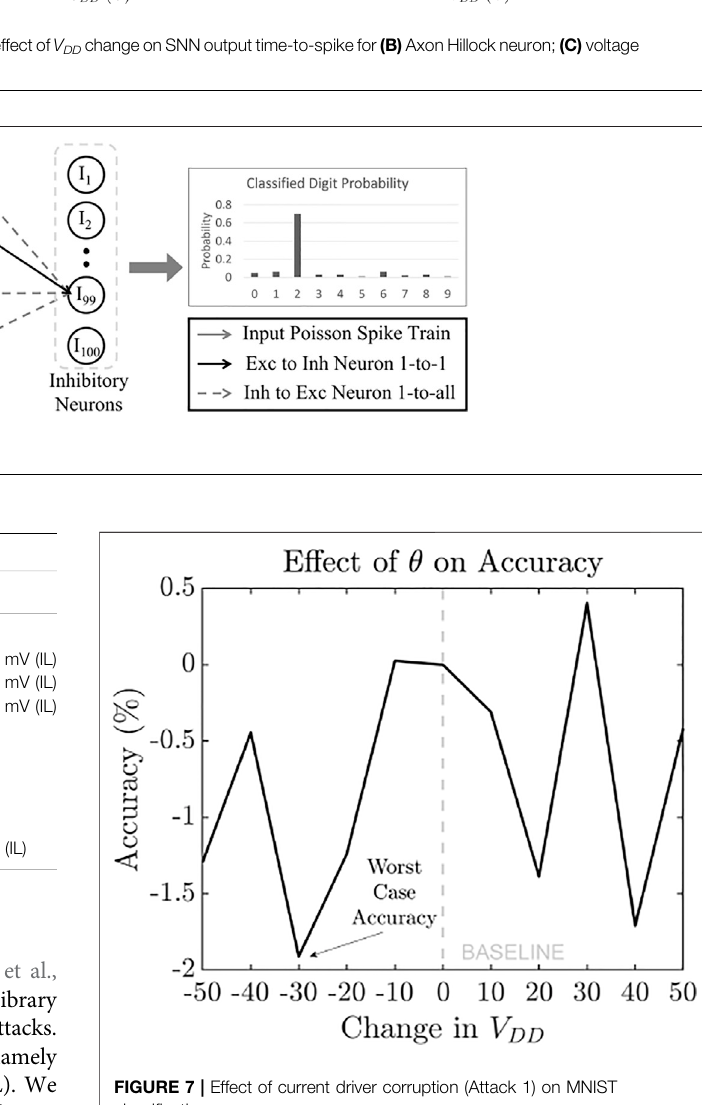
FIGURE 7 | Effect of current driver corruption (Attack 1) on MNIST classi fi cation